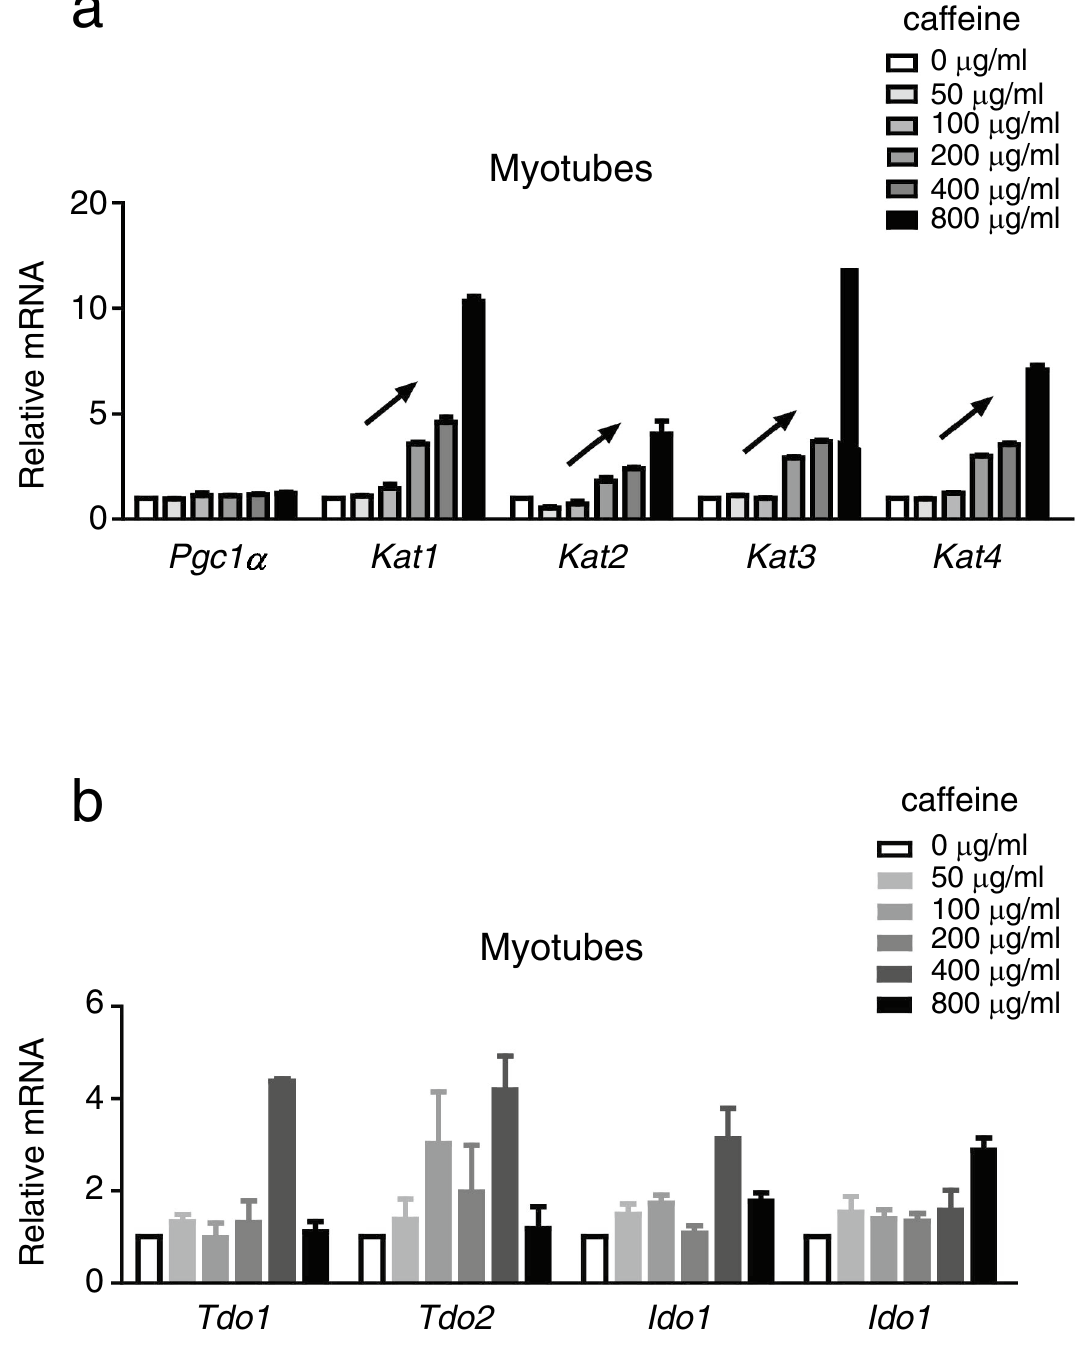
Figure 5. Caffeine induction of Kats but not Pgc-1α in myotubes. C2C12 myotubes were incubated with 400 μg/mL of caffeine for 24 h, and total RNA was prepared, followed by RT-qPCR for Pgc-1α ( a ), Kat1 ( a ), Kat2 the triplicate experiments. Similar results were obtained in three independent experiments. * p < 0.05; ** p < 0.01; *** p <